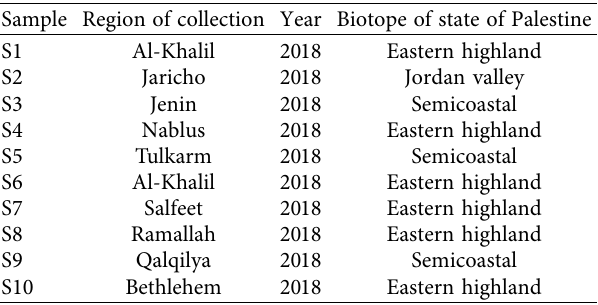
Table 1: Propolis samples, region of collection, and the biotope of these